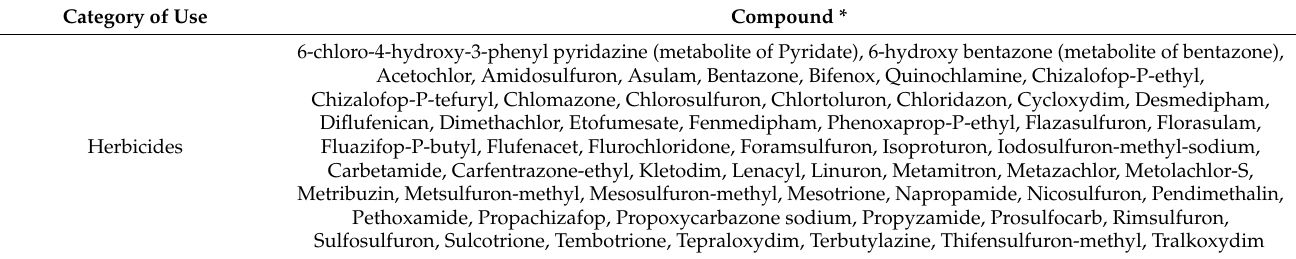
Table 1. List of analysed